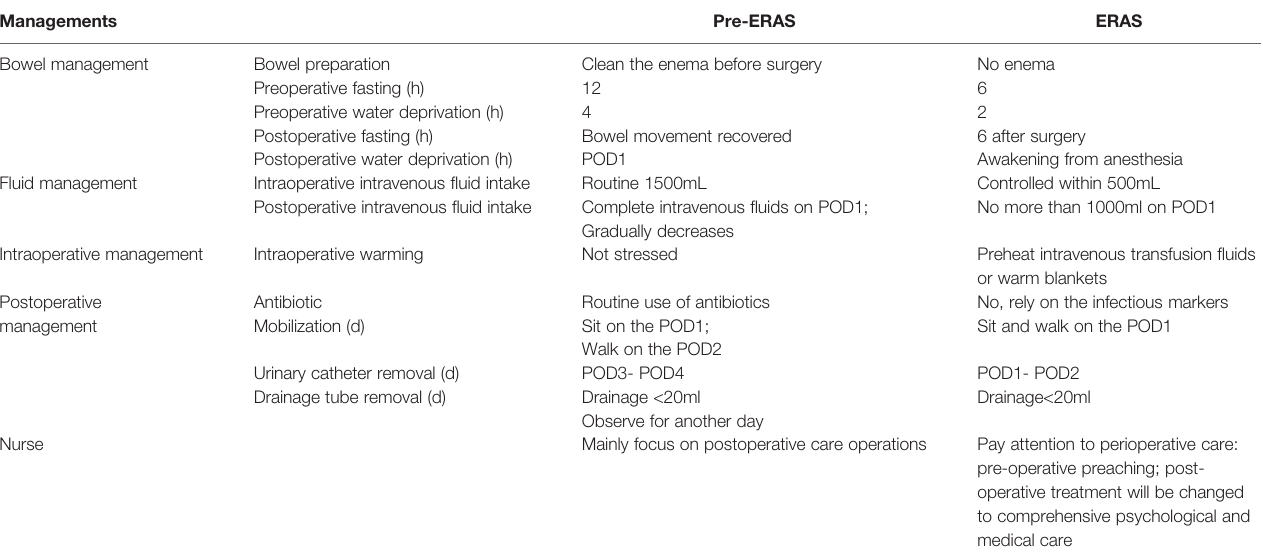
TABLE 1 | Enhanced recovery protocol for laparoscopic radical